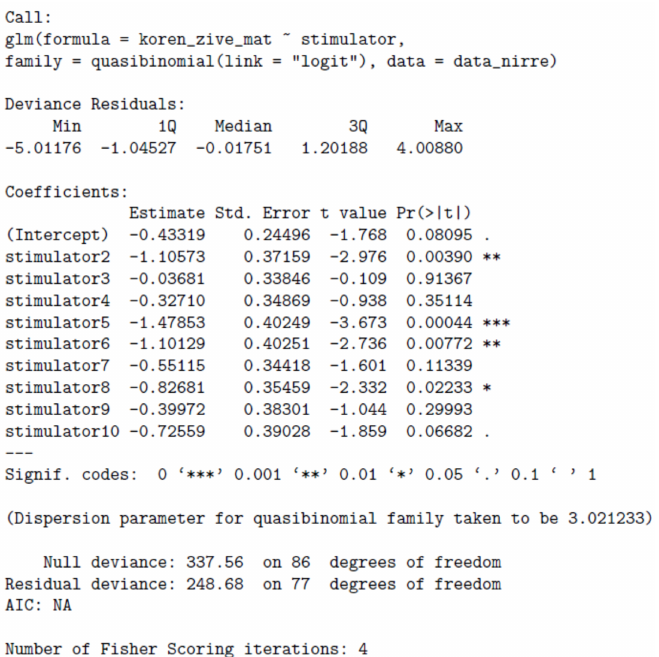
Figure A7. Parametrization of the simplified quasi-binomial model predicting the proportion of rooted cuttings from surviving cuttings, including Wald tests of the significance of differences between the reference Stimulator 1 and other stimulators.